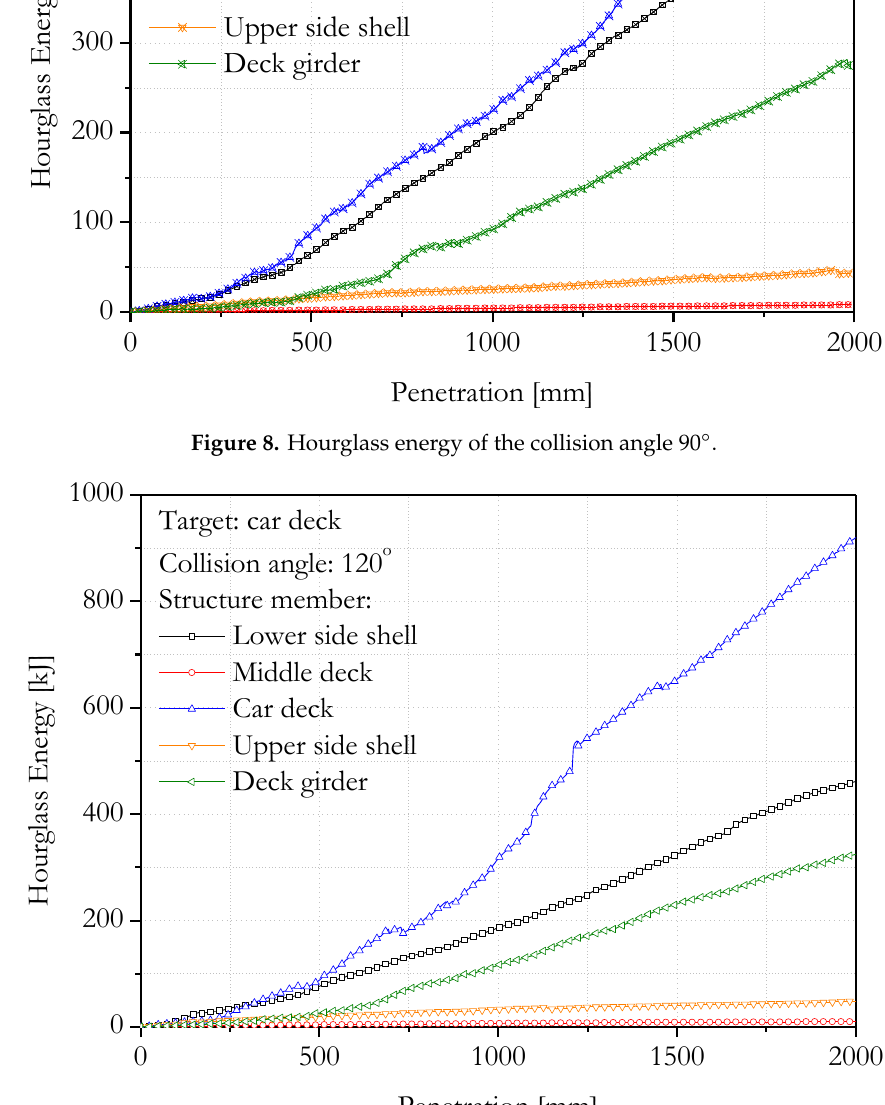
Figure 9. Hourglass energy of the collision angle 120°.